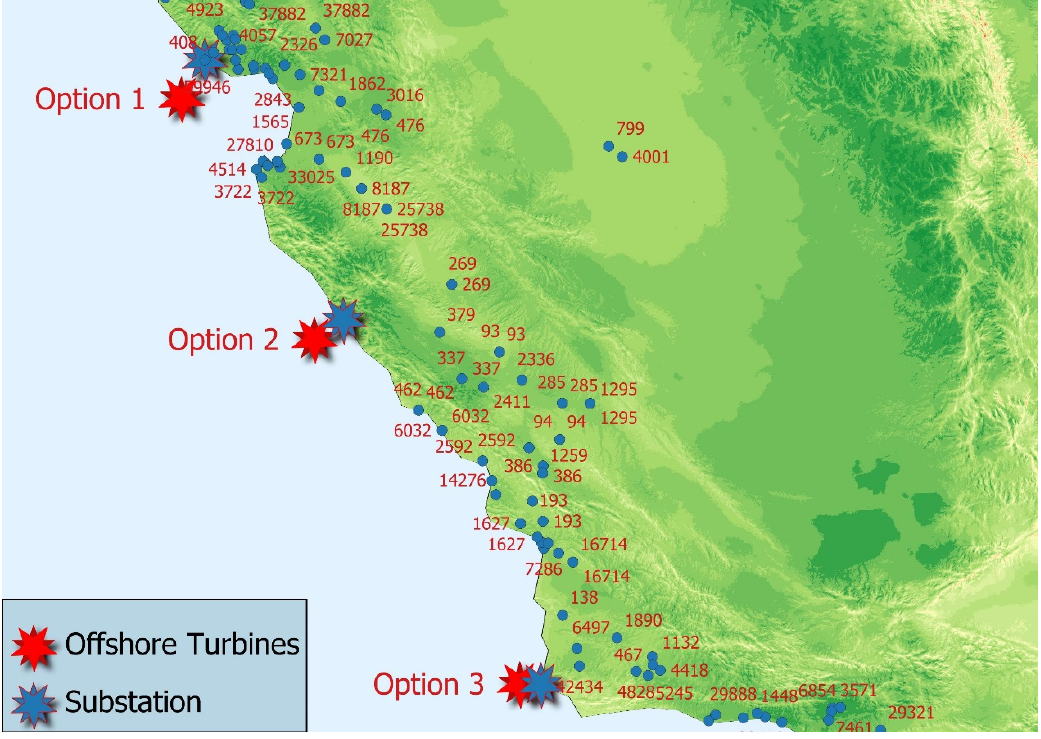
Figure 16. Location maps PSPS Cities near the three proposed offshore wind turbines sites between Davenport and Lompoc, Central California.